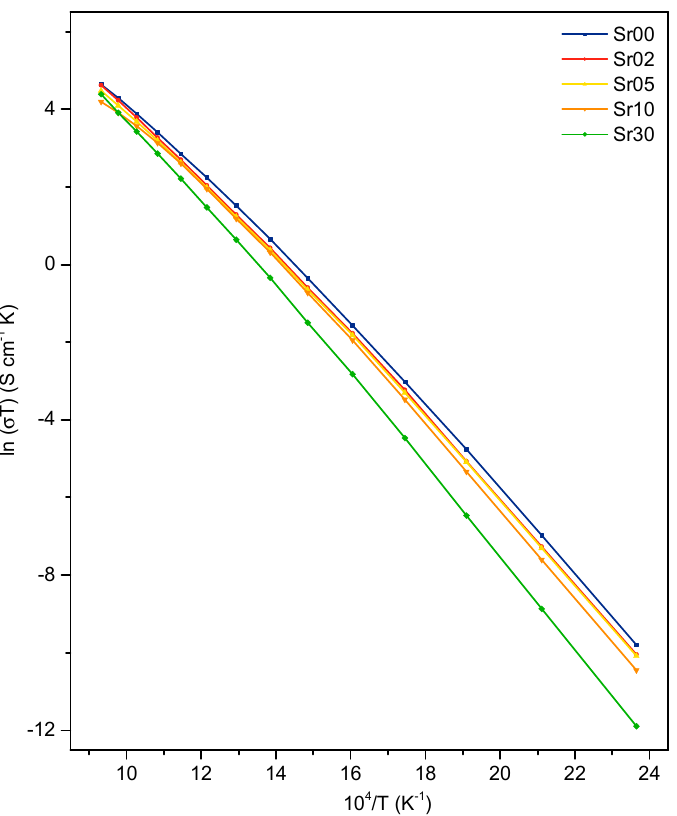
Figure 7. Arrhenius plot of total conductivity of the Ce 0.8 − x Sm 0.2 Sr x O 2 − δ samples indicated as a function of temperature from 150 °C to 800 °C.